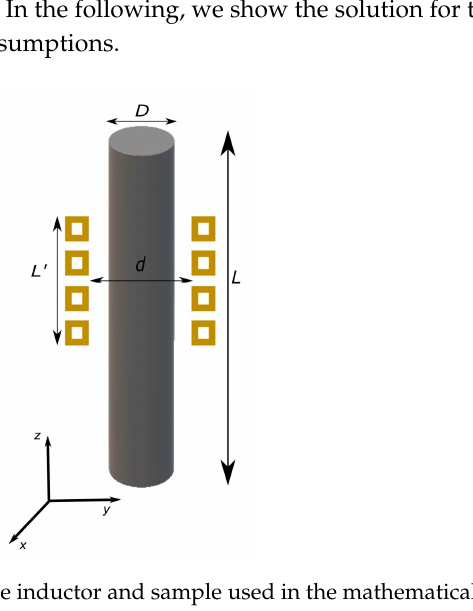
Figure 1. The geometries of the inductor and sample used in the mathematical